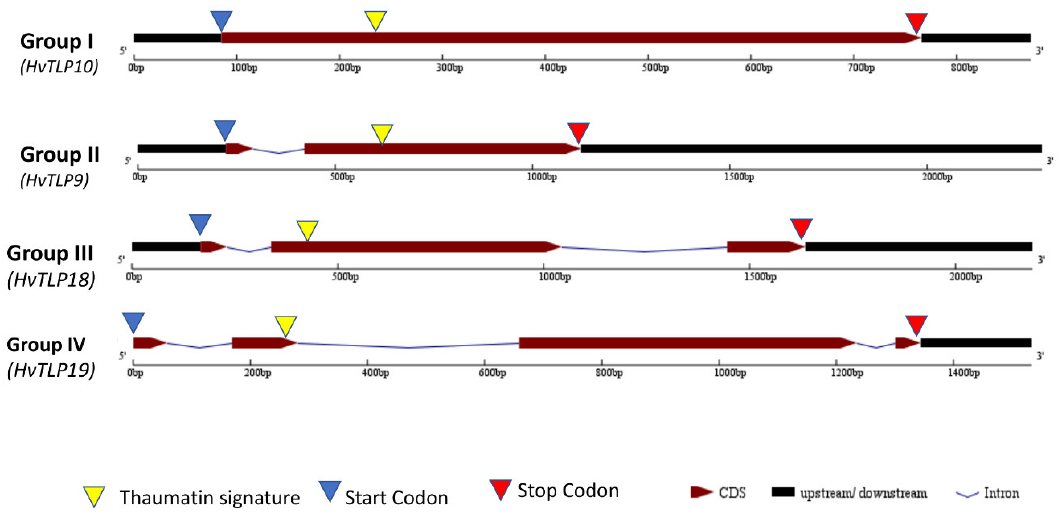
Figure 3. Structural features of barley TLP genes. From left to right is the 5′ to 3′ region containing untranslated region (UTR) in black, with maroon representing exons, blue triangles representing the start codons, red triangles for the stop codons, black narrow lines with slits symbolizing an intron and yellow triangles representing the thaumatin signature.